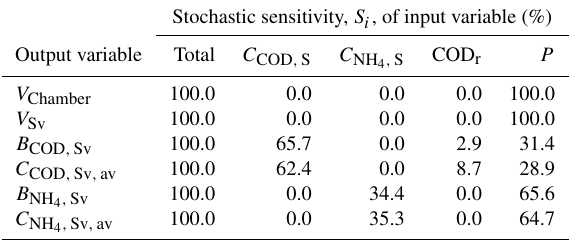
Table 5. Aggregated-over-time contribution of input variables to output variables in terms of percentage of total